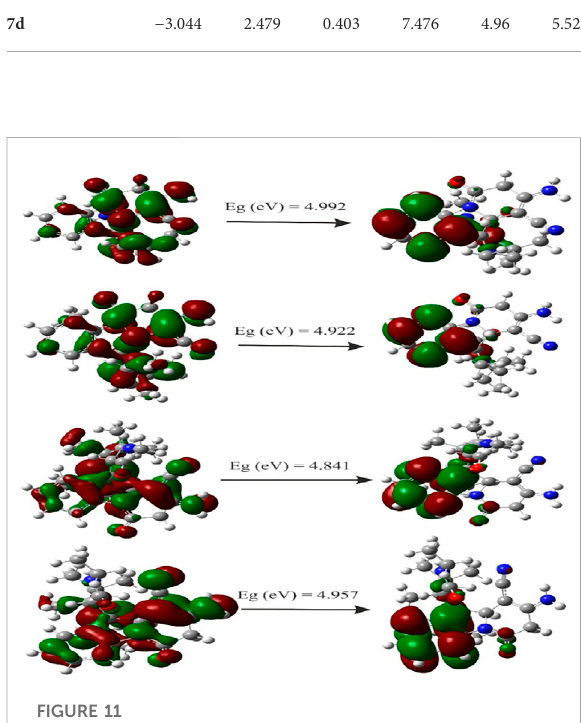
FIGURE 11 Plot HOMO and LUMO orbitals for 7a – 7d